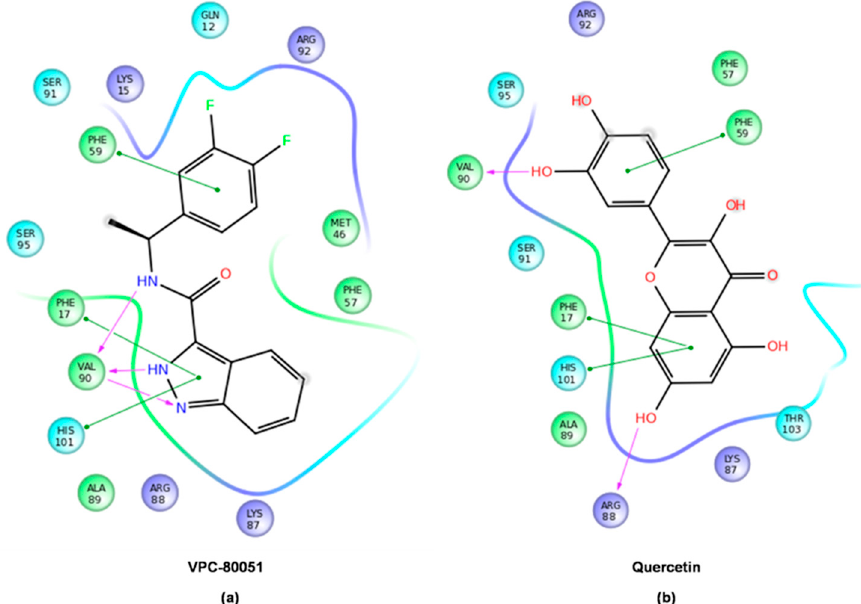
Figure 5. hnRNP A1-ligand interactions obtained from MM/GBSA simulations with implicit solvent for: ( a ) VPC-80051; and ( b ) quercetin in two-dimensional representation. Green lines indicate π - π interactions, purple arrow pointed lines represent backbone hydrogen-bonding interactions, and the curved contour represents the shape of the pocket around the ligand colored by the character of the interacting protein residues: (green = hydrophobic, blue = positively charged, cyan = polar).